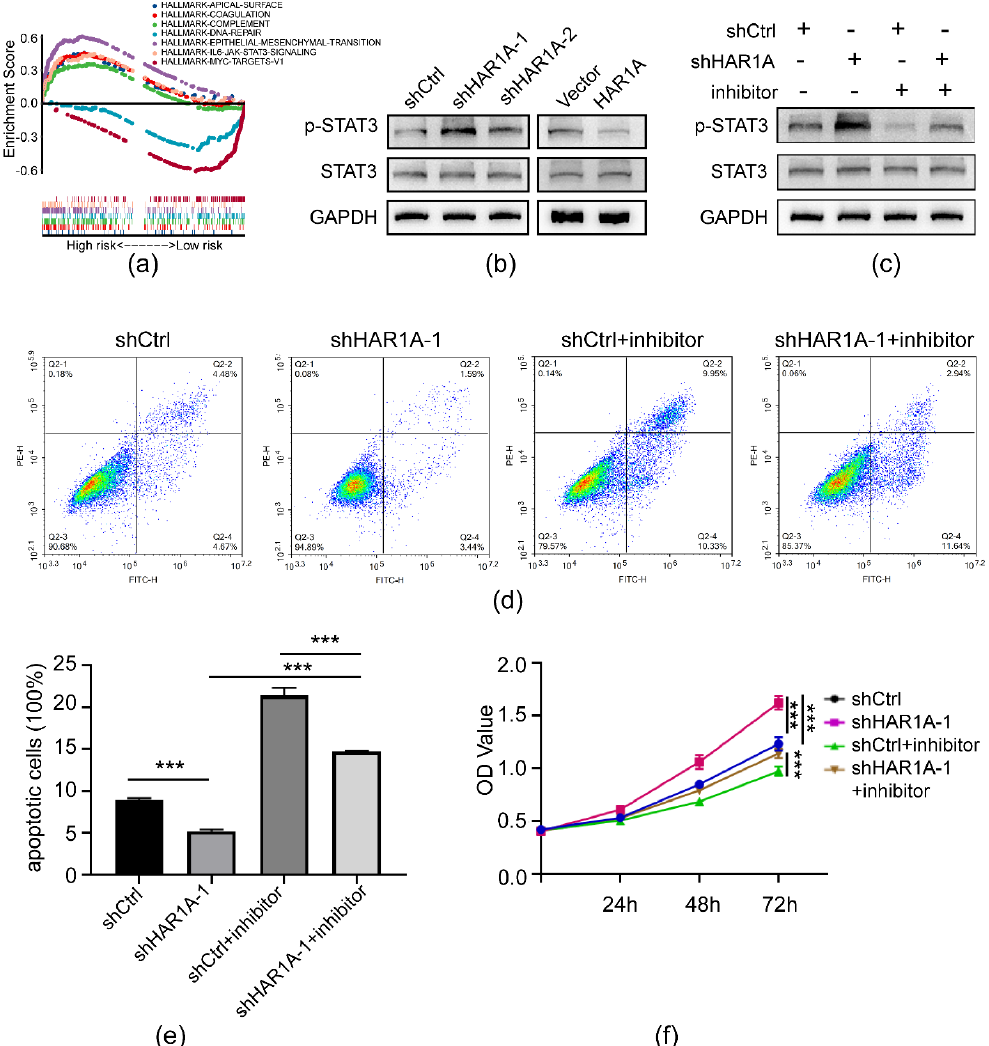
Figure 7. lncRNA HAR1A regulated NSCLC cell proliferation and apoptosis via the STAT3 signaling pathway. ( a ) GSEA revealed that the IL-6-JAK-STAT3 pathway was associated with lncRNA HAR1A in NSCLC cell lines. ( b ) Western blot was used to detect expression and phosphorylation levels of STAT3 under the influence of the knockdown or overexpression of lncRNA HAR1A . ( c ) shCtrl and sh HAR1A cells and controls were treated with or without STAT3 inhibitor, Stattic. Western blot was performed to examine the levels of the indicated proteins. ( d , e ) Cell apoptosis was determined by flow cytometry. ( f ) Cell proliferation was measured by CCK8. The experiments were performed in triplicate, and data were calculated from three independent experiments using statistical analysis. ***, p < 0.001.